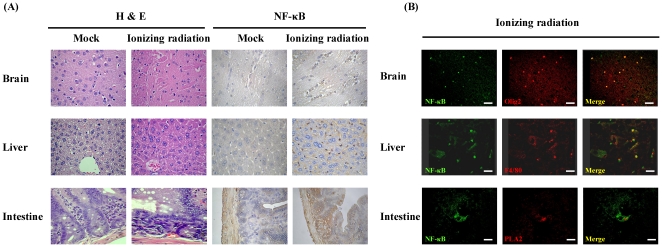
Histological examination, immunohistochemical staining, and immunofluorescence staining of organs exposed to ionizing radiation.(A) Histological examination and immunohistochemical staining. Transgenic mice were exposed to irradiation. Three hours later, mice were sacrificed, organs were excised, and the sections were stained with H&E or by immunohistochemistry using antibody against NF-κB (400× magnification). Photos are representative images (n = 6). (B) Immunofluorescence staining. Sections from irradiation-exposed organs were stained with antibodies against NF-κB (green) , olig2 (ref), F4/80 (ref), or PLA2 (ref). Overlap of markers appears as yellow color in the right panels. Scale bars = 10 µm. Photos are representative images (n = 3).